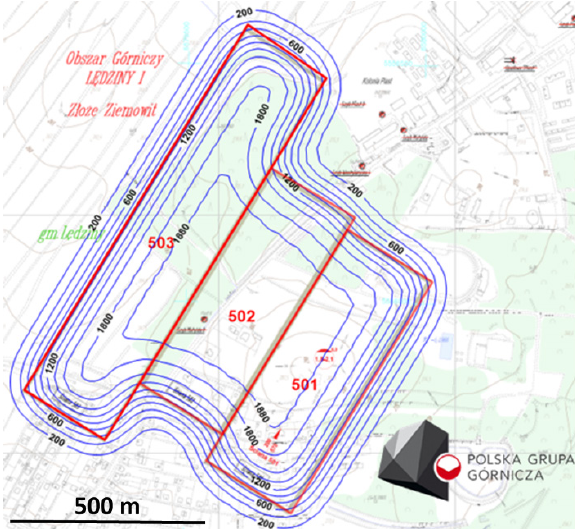
Figure 10. Underground mining, operated by PGG, in Lędziny , Poland. Mining begun in area 501 since June, 2021, followed by 502 and then 503.